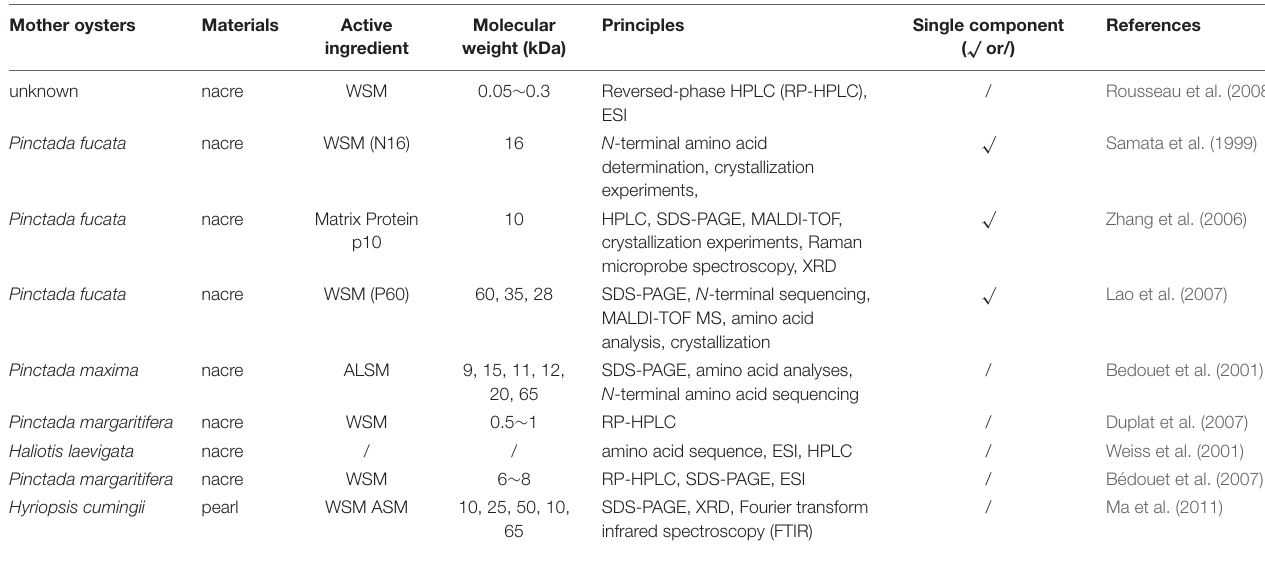
TABLE 5 | Summary of the structure of nacre powder